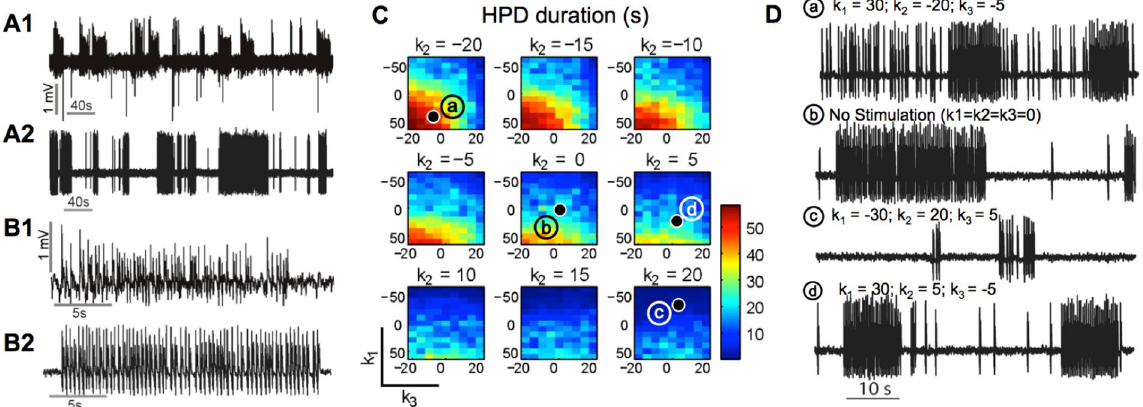
Figure 1. Effects of Local Direct Current Stimulation (LDCS) on HPD characteristics in the computational model. ( A1 ) Example of experimentally recorded local field potential (LFP) recording in a KA mice, showing numerous HPD in the signal. ( A2 ) Simulated LFP corresponding to ( A1 ). ( B1 ) Zoom on an experimentally recorded HPD. ( B2 ) Zoom on the corresponding simulated HPD. ( C ) Mapping of different values for the stimulation coupling coefficients (k 1 , k 2 , k 3 ) triplet, the color scale indicating the mean HPD duration for each triplet value. ( D ) Simulated LFP traces for the (a), (b), (c) and (d) triplet